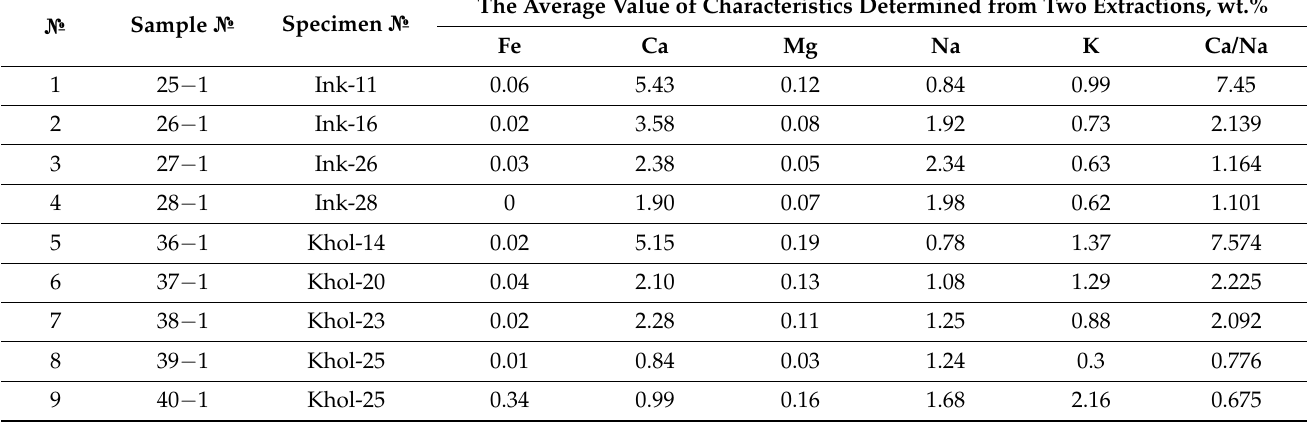
Table 7. Content of main salt components in water extractions from FIs in